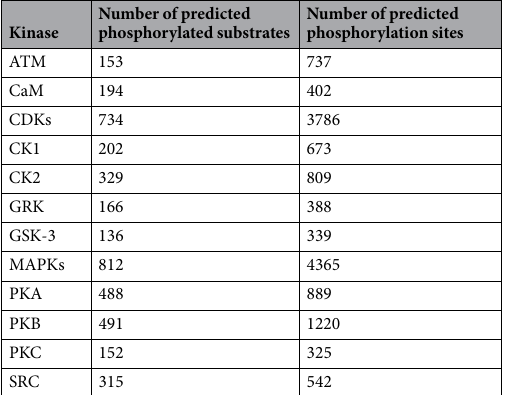
Table 7. Proteome-wide kinase-specific phosphorylation site predictions. Predictions used a cutoff value of 0.8, which corresponded to a specificity of 99%. Prediction was performed for the whole human proteome with a